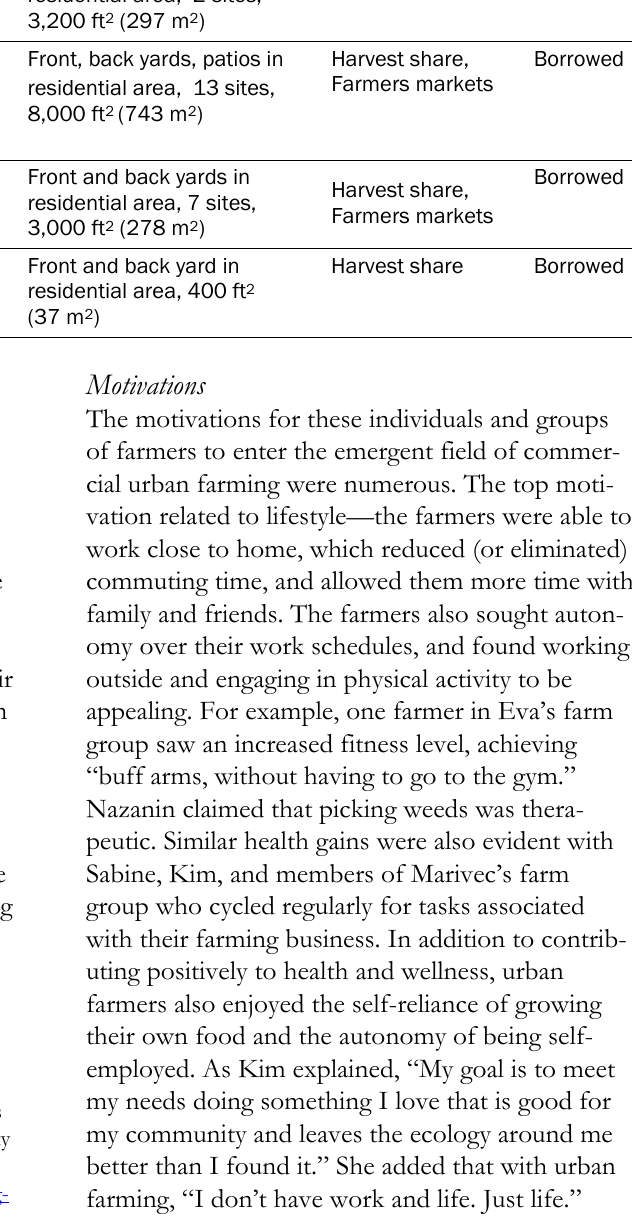
Table 1. The Urban Farmers Farmer / Farm Group